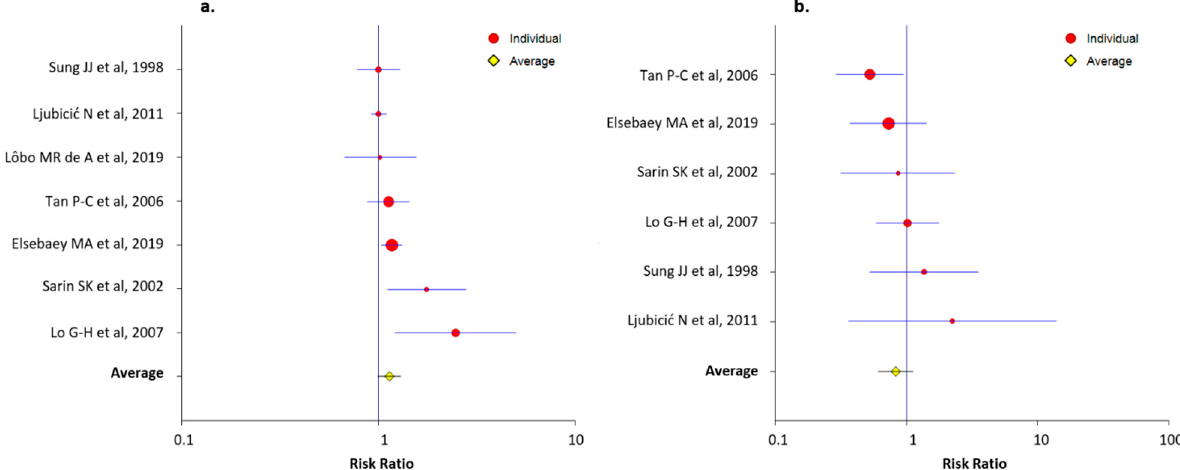
Figure 4. Forest plots presenting the risk ratios of the technical success ( a ) and the 30-day rebleeding ( b ) rates for each randomized controlled trial that compared NBCA-Lipiodol ® injection to another treatment method.